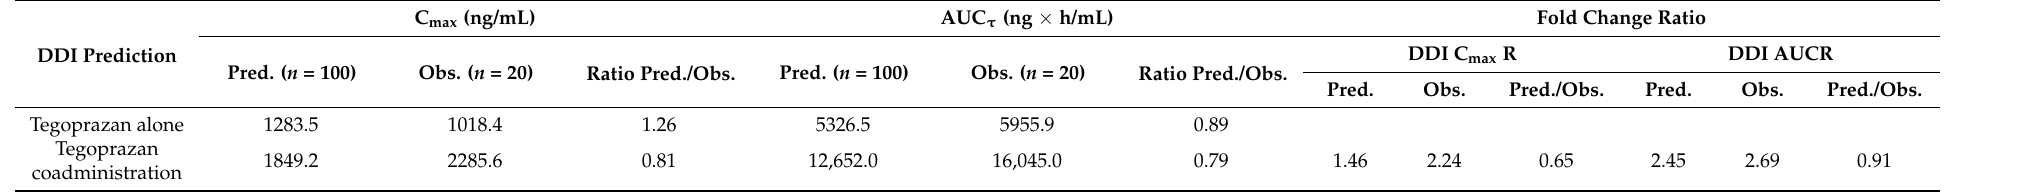
Table 1. The observed and predicted mean C max , AUC τ , their ratios, and the fold change ratios for drug–drug interaction simulation. C max (ng/mL) DDI Prediction